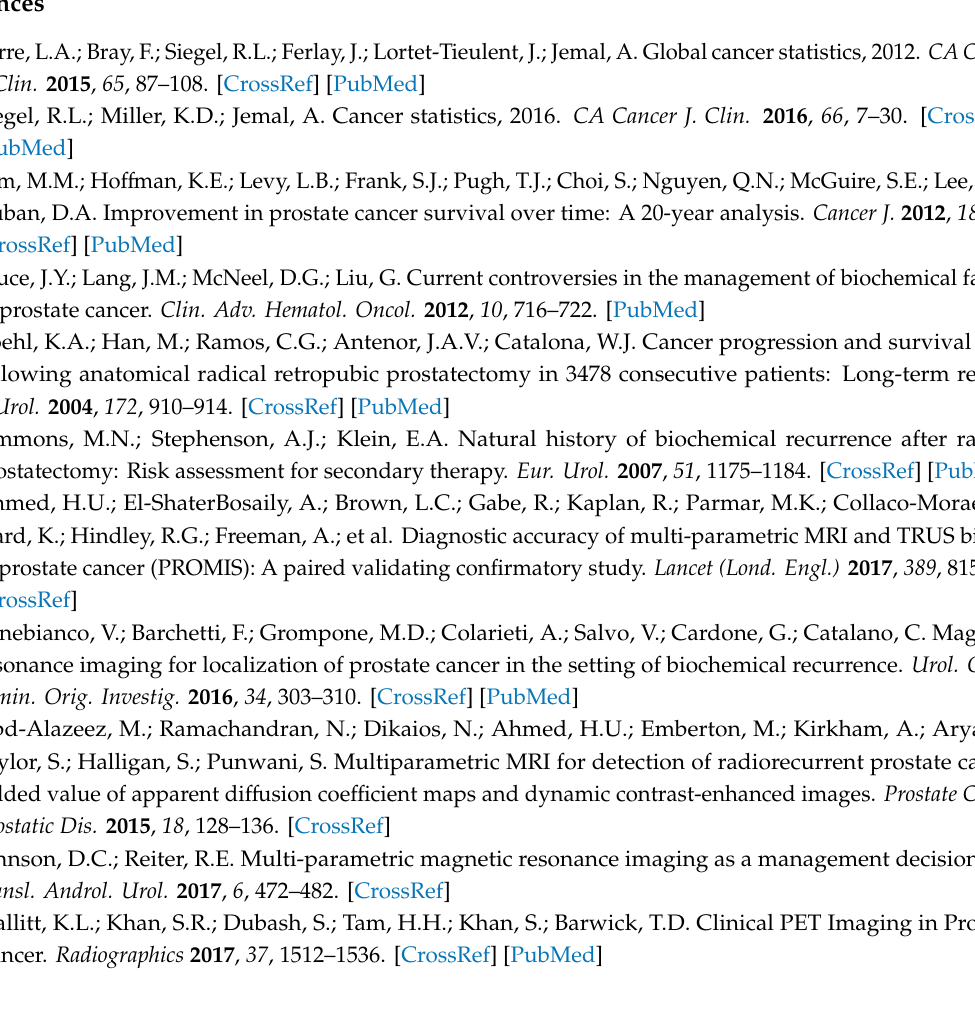
Table S1: QUADAS 2 score for each selected study (green smile = low risk; red smile = high risk; yellow question mark = unclear). Figure S1: Forest-plots for the patient-based and region-based analysis. Figure S2: ROC curves for patient-based and region-based